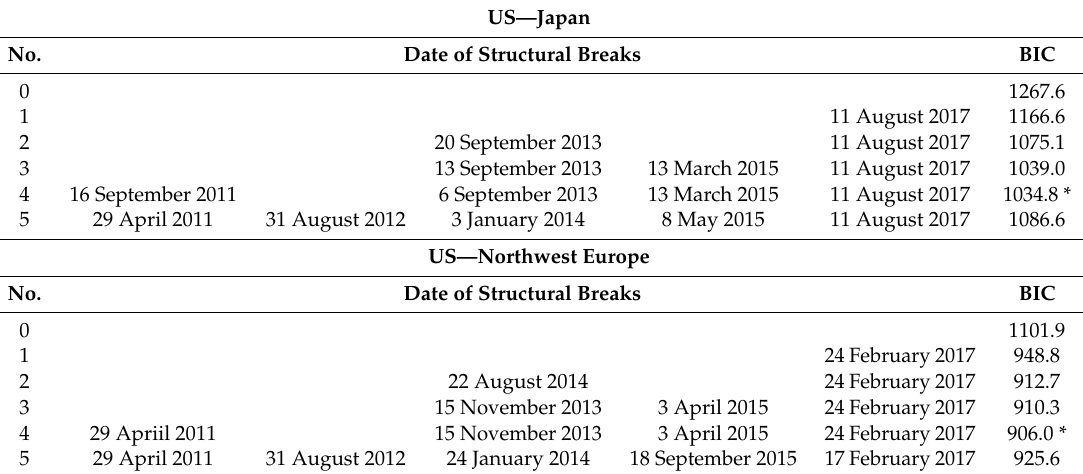
Table 6. Structural changes in regional ethylene